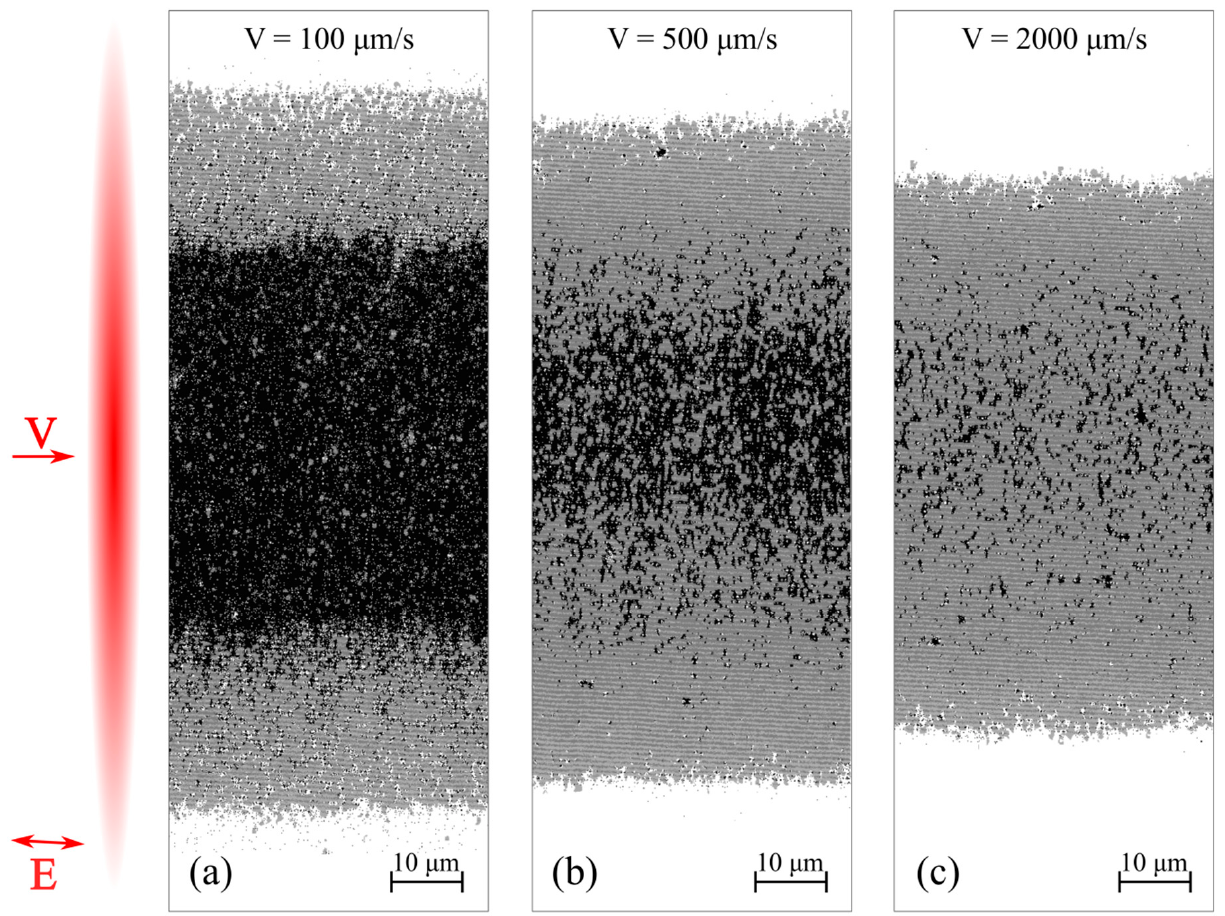
Figure 8. Processed SEM images formed in a low vacuum at a power of 250 mW and different scanning speeds: 100 µ m/s ( a ), 500 µ m/s ( b ), 2000 µ m/s ( c ). The inset shows schematically the astigmatic beam, directions of scanning and polariza- tion.